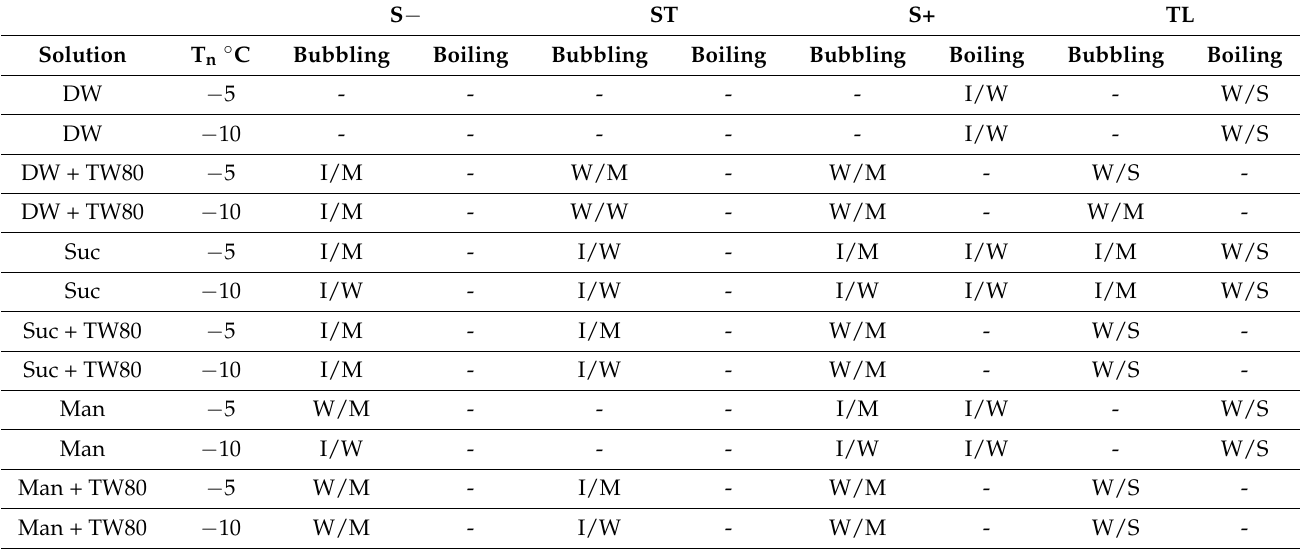
Table 3. Diffusion and intensity of bubbling and boiling phenomena for the different solutions and vial types considered in this work. S − : untreated, ST: sulfate treated, S+: siliconized, TL: TopLyo. Diffusion scale: I isolated, W widespread. Intensity scale: W weak, M moderate, S